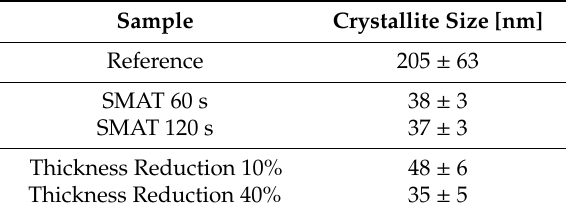
Table 1. Calculated values of lattice crystallite size for magnesium samples.